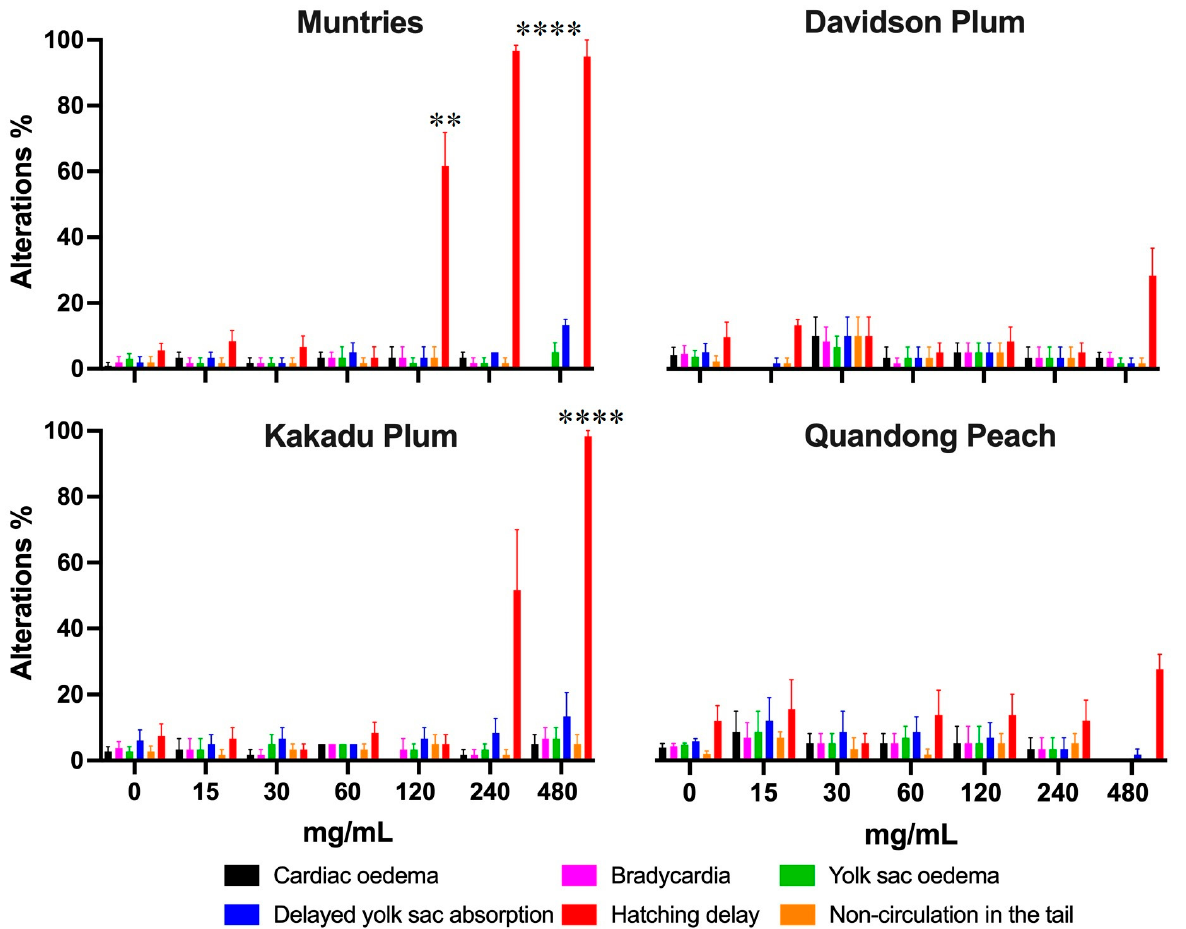
Figure 6. The graph shows the developmental alterations and morbidity in zebrafish embryos exposed for 96 h to different concentrations of native Australian fruits. Bars represent the mean ± SEM compared to the control group ( p < 0.0001). Statistical significance represented by ** p ≤ 0.01, and **** p ≤ 0.0001.